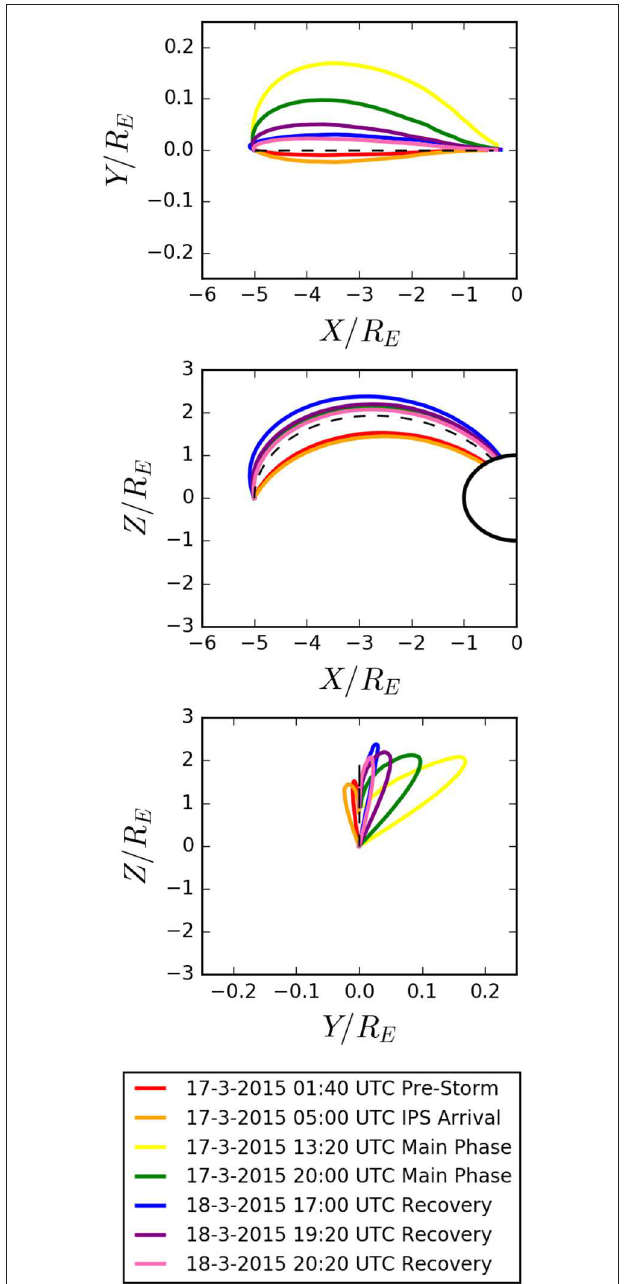
FIGURE 5 | Trajectories of beam particles emitted from phases of the 2015 St. Patrick’s Day magnetospheric